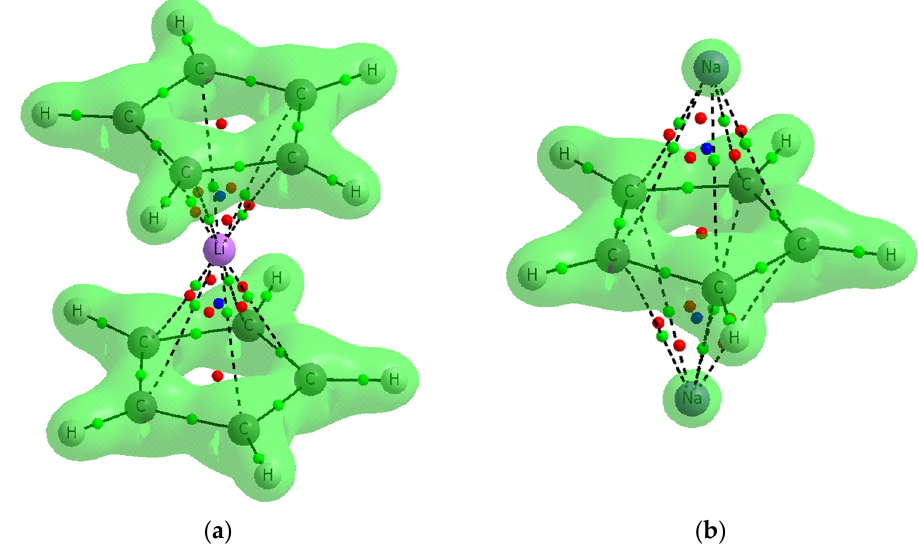
Figure 7. The examples of two complexes analyzed here where contours of the ∇ 2 ρ = 0 surfaces are presented: ( a ) C 5 H 5 − Li + C 5 H 5 − ( b ) Na + C 5 H 5 − Na + .